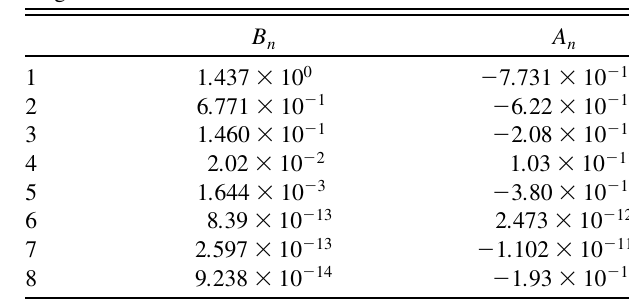
TABLE VIII. Field harmonics of the PAMELA carbon magnet.